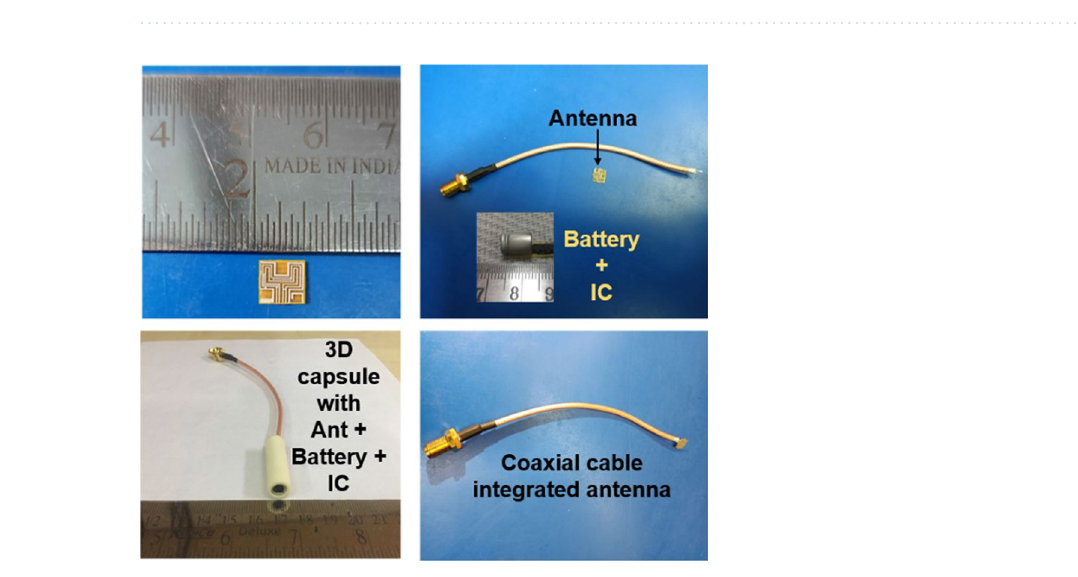
Figure 17. Fabricated prototype of the antenna and 3D printed ceramic alumina capsule with cable integrated antenna and dummy